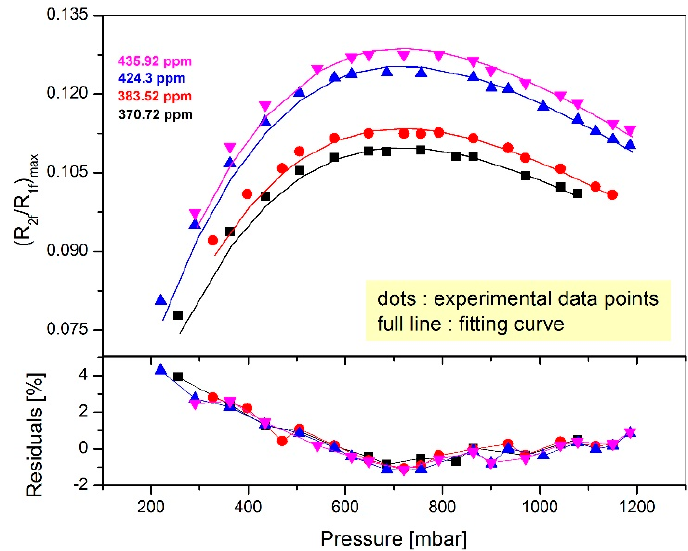
Figure 5. Experimental data at 15 °C, represented by points on the upper panel and their corresponding fit to the model described by Riecker [11,12] in continuous lines for the four different concentrations tested in the atmospheric enclosure. The lower panel shows the residuals of the applied fitting. The residual is about 4% at lower pressures and is reduced at 1% for the pressures around 660 mbar which correspond to our optimized modulation depth of 2.2. This fitting technique is limited by the Lorentzian profile which works better at higher pressures.